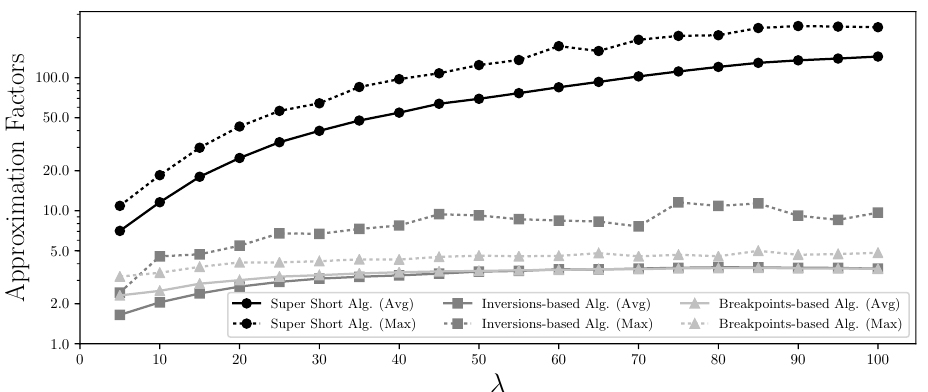
Figure 3. Average and maximum approximation factors of the algorithms for Sorting Signed λ - Permutations by λ -Operations, with random λ -permutations generated from ι of size 100 as inputs. Note that a logarithmic scale is used in the y-axis of each graph.